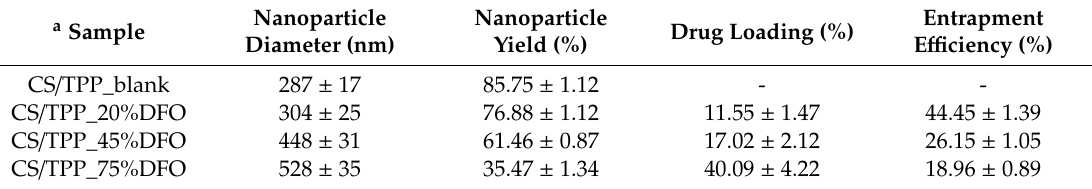
Table 3. Nanoparticle size, yield (%), drug loading (%) and entrapment efficiency (%) of CS/TPP/DFO at various DFO concentrations.